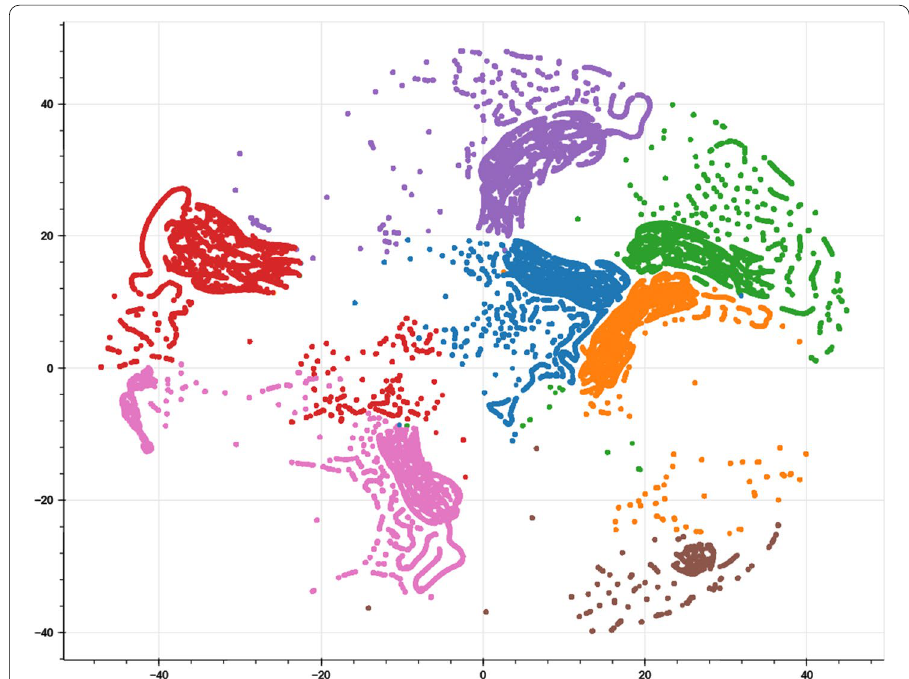
Fig. 5 2-D Representation of the Data Using